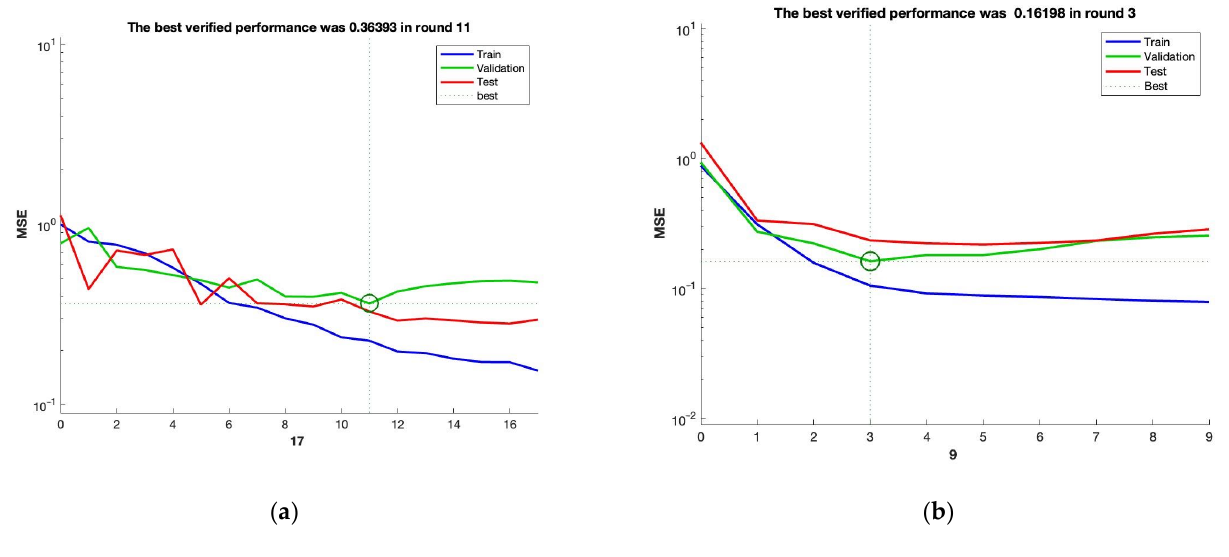
Figure 5. ( a ) is an iterative graph of the prediction of the Rmax of the surface roughness by the BP model; ( b ) is an iterative graph of the prediction of the Rmax of the surface roughness by the CPA-BP model.